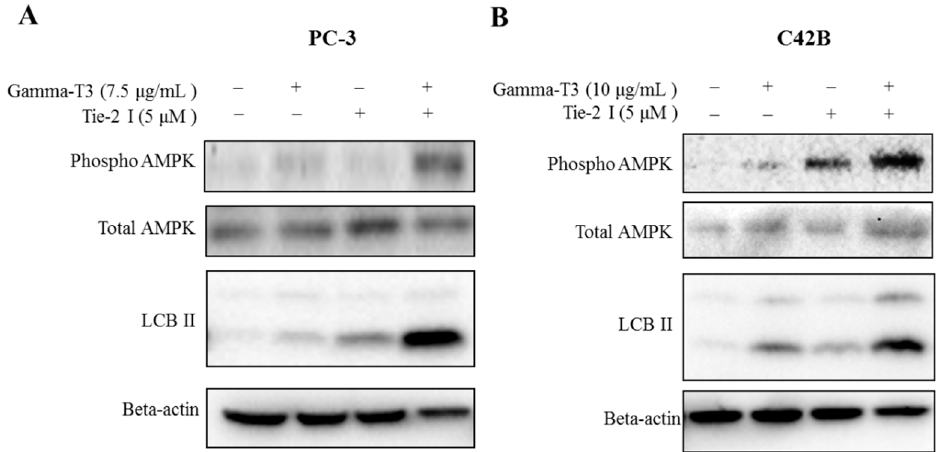
Figure 4. Combination of Tie-2 inhibitor and γ -T3 lead to activation of AMPK. PC-3 ( A ) and C42B ( B ) cells were treated with the indicated compounds for 48 and 72 h, respectively. Western blotting was performed to determine the level of phospho-AMPK α (Thr172), total AMPK, LCBII, and actin in both PC-3 and C42B cells. Note that the combined effect of Tie-2 inhibitor and γ -T3 led to a clear induction of phospho-AMPK α and LCBII expression in both PC-3 and C42B cells. Each experiment was repeated at least three times with representative Western blots shown.